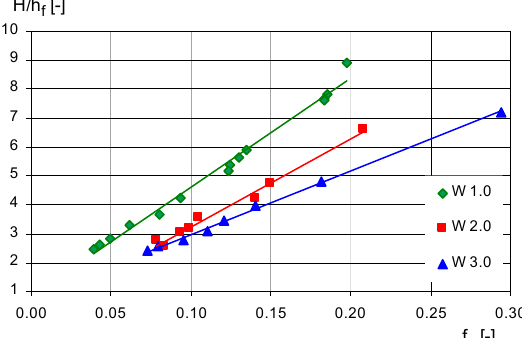
Figure 7. Variability of apparent resistance coefficients in a compound channel cross-section in variants W 1.0, W 2.0 and W 3.0 as a function of the flow depth.